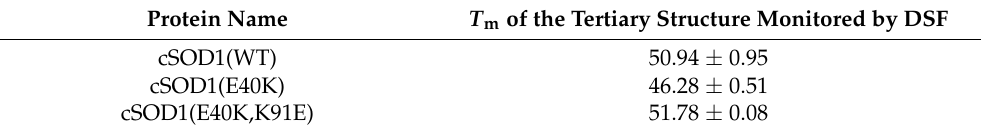
Figure 2. Thermal unfolding of cSOD1 WT and mutants monitored by differential scanning fluorimetry (DSF). ( A ) DSF curves of cSOD1(WT) (solid line), cSOD1(E40K) (dotted line), and cSOD1(E40K,K91E) (dashed line). ( B ) Comparison of the melting temperature ( T m ) of cSOD1(WT) and mutants. Table 1. The melting temperature ( T m ) of tertiary structure of cSOD1s obtained by DSF.